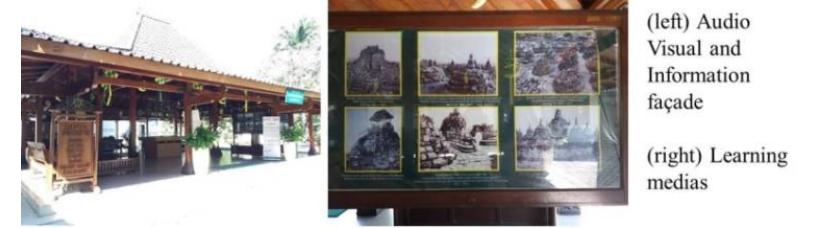
Fig. 8 Audio Visual and Information